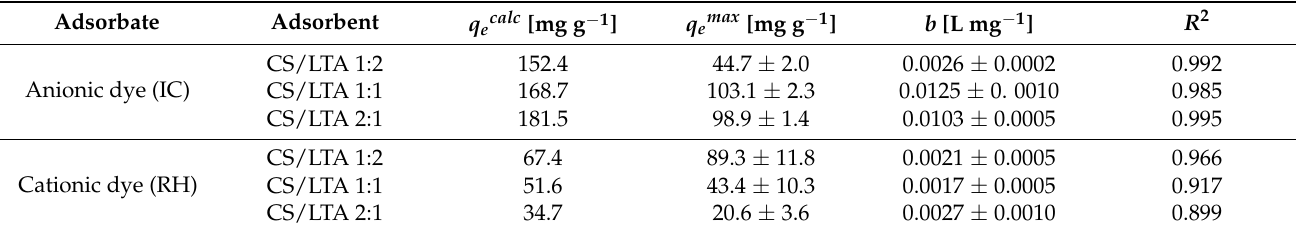
Table 2. Langmuir model best fitting parameters for adsorption isotherms for hybrid CS/LTA aerogels.